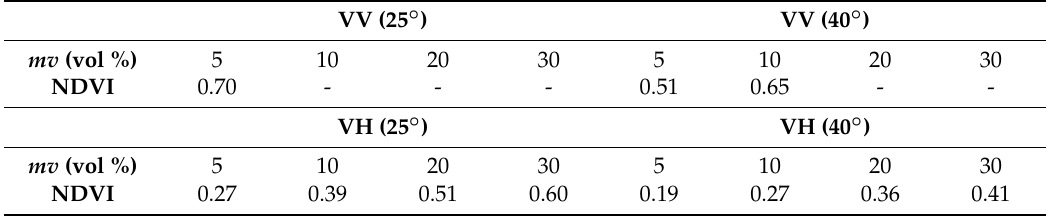
Figure 5. Behavior of WCM components ( σ 0veg , T 2 σ 0soil , and σ 0tot ) in VV and VH polarizations according to NDVI for 25° and 40° incidence angles, mv = 20 vol %, and Hrms = 2 cm. ( a ): VV and θ = 25°; ( b ): VV and θ = 40°; ( c ): VH and θ = 25°; ( d ): VH and θ = 40°. The NDVI thresholds from which the soil’s contribution (T 2 σ 0soil ) is lower than the vegetation’s contribution ( σ 0veg ) are given in Table 3. The threshold values in VV with 40° incidence angle are approximately 0.51 and 0.65 for soil moisture of 5 and 10 vol %, respectively. Results show that the soil contribution begins to dominate the vegetation contribution at 40° for mv -values higher than 10 vol %. The comparison between results obtained at 25° and 40° shows that the NDVI thresholds are higher at low incidence angle (25°) than at high incidence angle (40°) where the σ 0veg is almost always dominated by T 2 σ 0soil (Table 3). Table 3. Threshold values of NDVI at which vegetation contribution σ 0veg dominates soil contribution T 2 σ 0soil at VV and VH polarizations. Dash symbols mean that the σ 0veg is always dominated by T 2 σ 0soil (see Figure 3). The soil roughness Hrms was fixed to 2 cm.